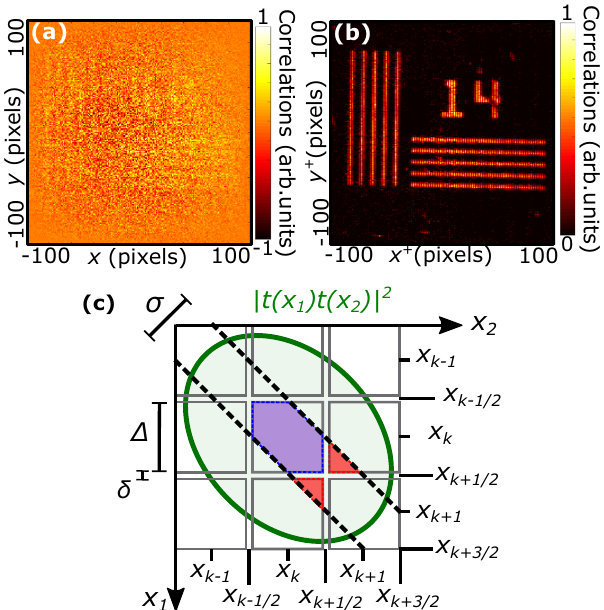
Fig. 5 Filtering and normalization. a Sum-coordinate projection of the JPD P + measured in the experiment in Fig. 3 without fi ltering. b Sum-coordinate projection of the JPD P + measured in the experiment in Fig. 3 after fi ltering and before normalisation. c Graphical representation of Eq.